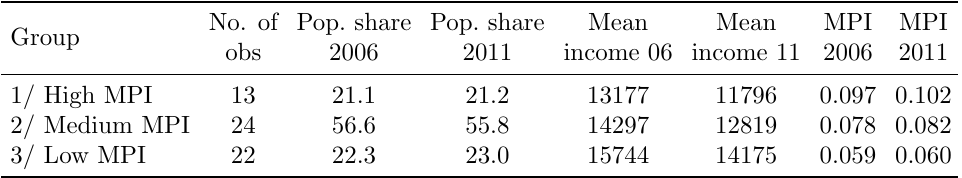
Table 4: Main characteristics of three clusters